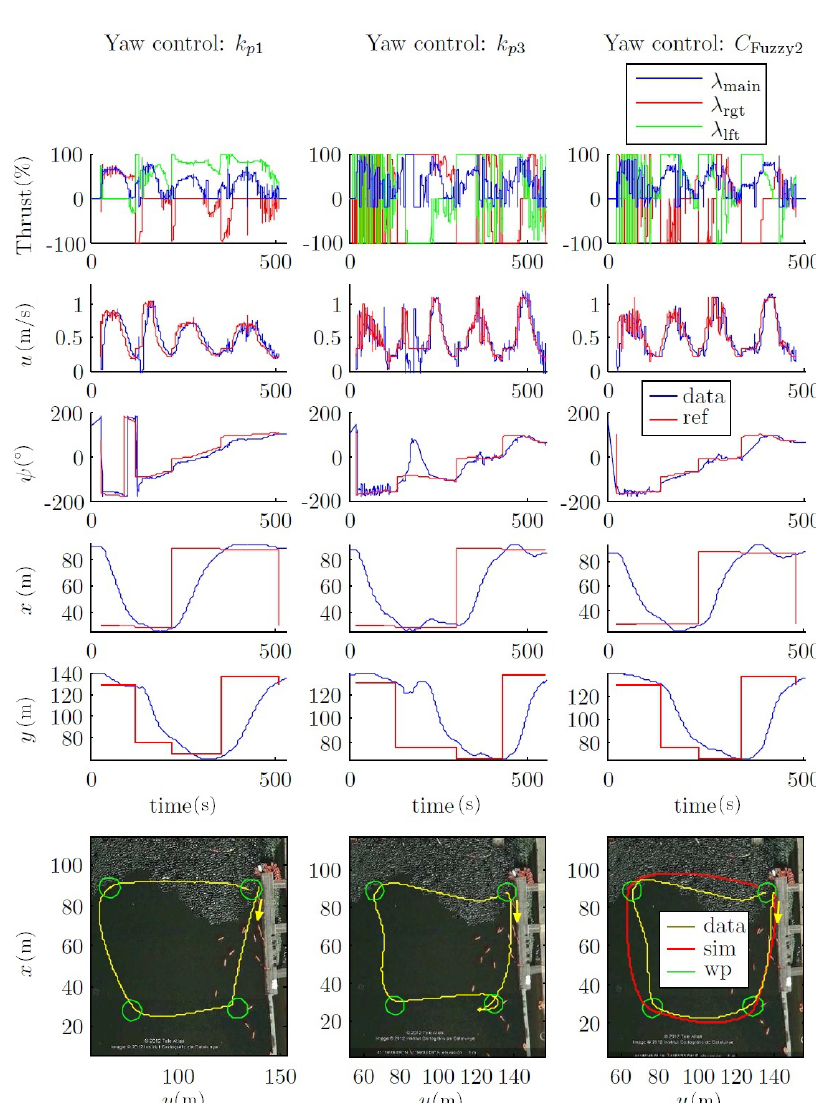
Figure 27. Field tests. Outer loop fuzzy control. Comparison of C Fuzzy 2 with proportional controllers. Path 2. u = 1